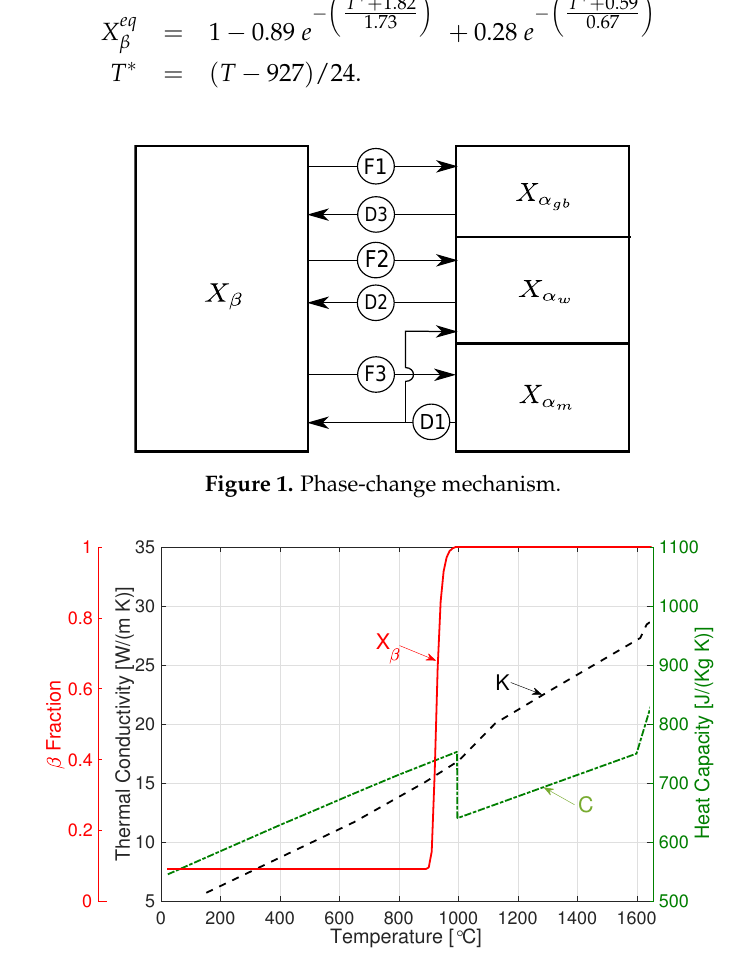
Figure 2. Thermal conductivity (K), specific heat capacity (C) and equilibrium-phase fraction ( X β